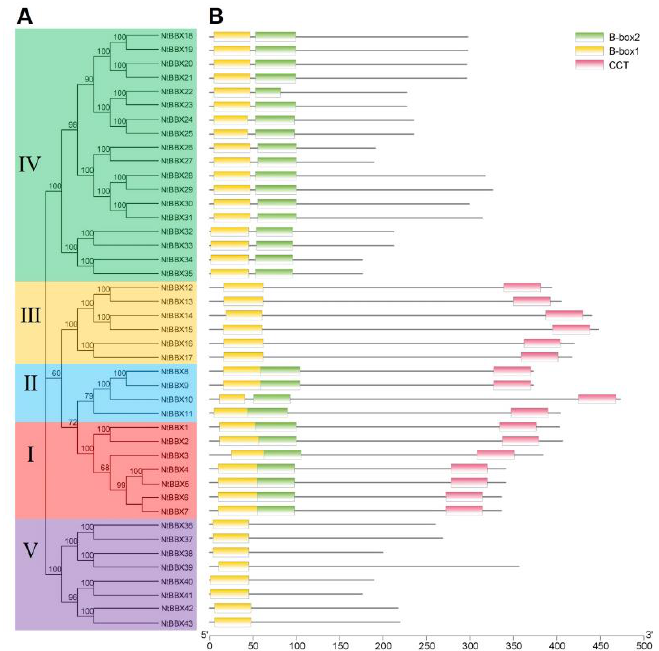
Figure 2. Conserved domains of NtBBX proteins. ( A ) Phylogenetic tree of NtBBX proteins sequences from tobacco. The phylogenetic tree was constructed using MEGA-X with the Neighbor-Joining (NJ) method with 1000 bootstrap replications; ( B ) Conserved domains of NtBBX. B-box1 domains are indicated by yellow boxes, B-box2 domains are indicated by green boxes, and CCT domains are indicated by pink boxes.